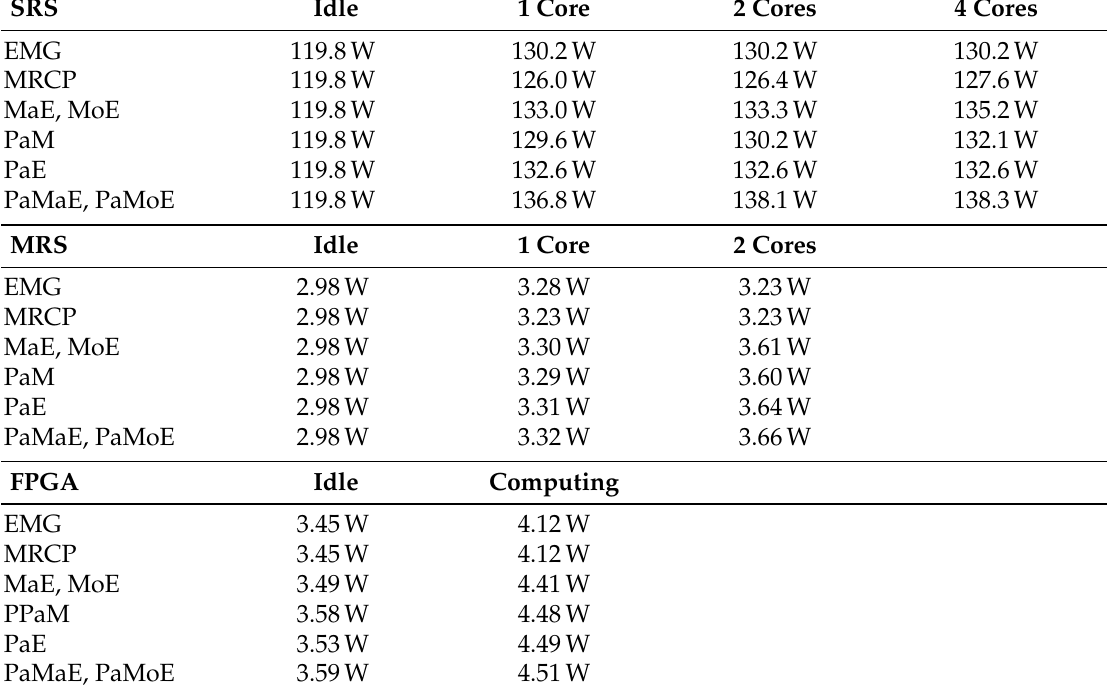
Table 4. Power consumption, reference versus FPGA-based system with different